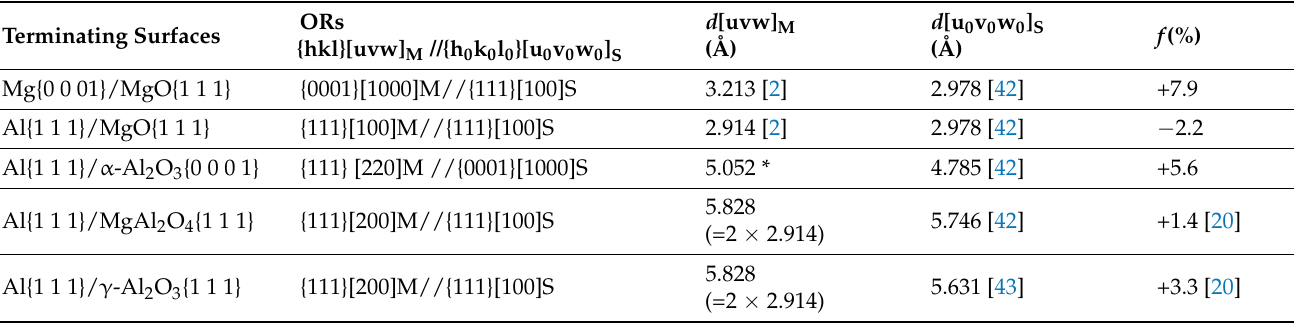
Table 2. Terminating surfaces, orientational relations (ORs) and lattice misfits between metals (M) and the oxide substrates (S), M/S [2]. The lattice misfit is defined as: f = ( d M − d S )/ d M × 100%, where d S represent the lattice spacing of the oxide and d M of the metal. Data from the literature [20] are